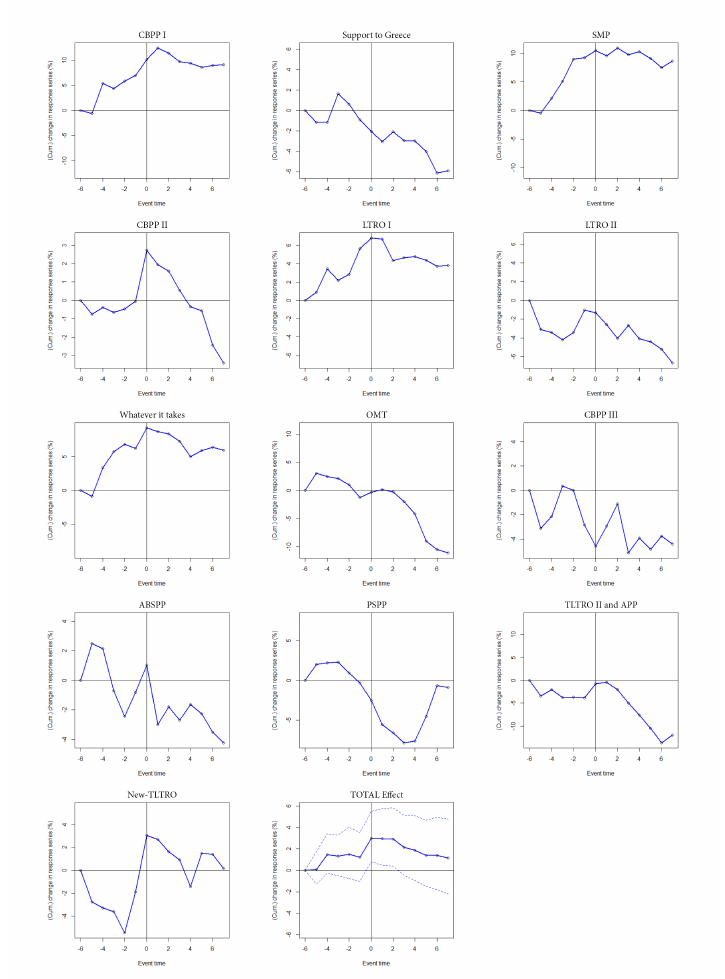
Figure A4. Each figure refers to CAC ˆ ρ t 10 days before and after the event